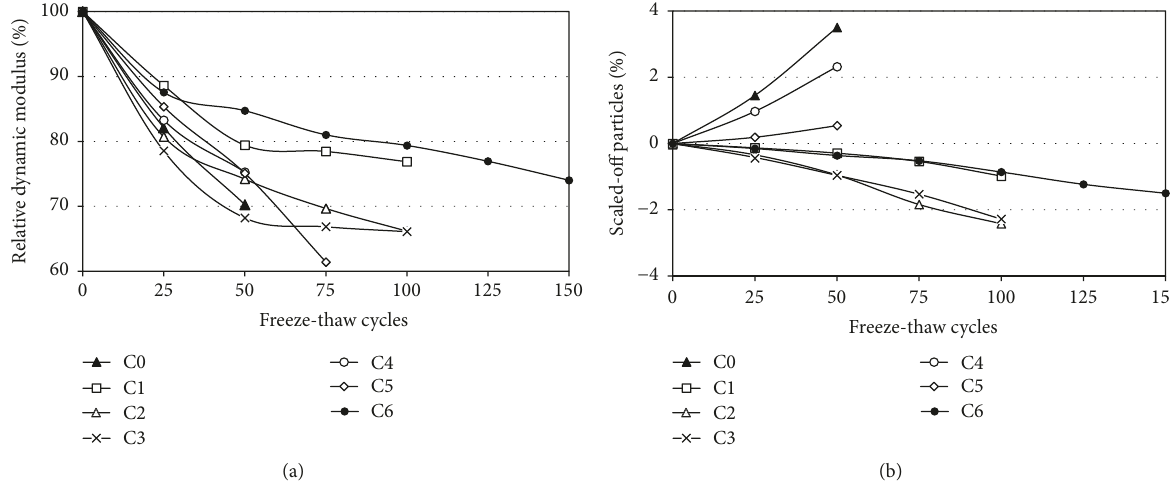
Figure 10: Coated concrete samples under freeze-thaw cycles: (a) relative dynamic modulus and (b) percentage of scaled-off mass.